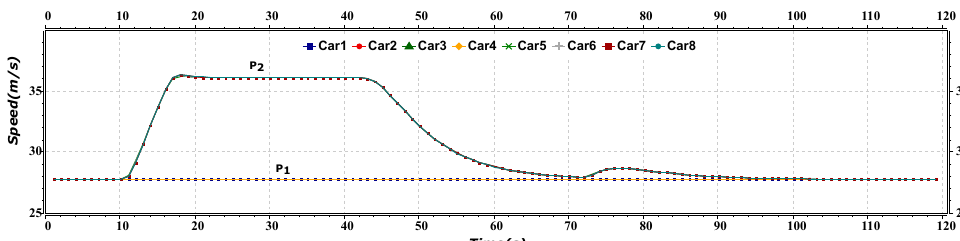
reducing its speed to merge into the first platoon. After merging, the platoon’s AVs move at a constant speed agaiuntil the destination.